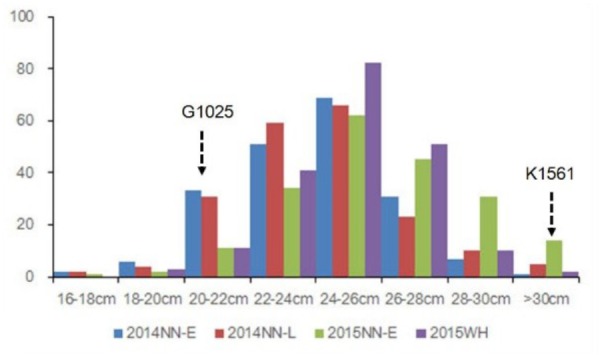
Phenotypic evaluation of PL for G1025, K1561, and RILs. The Y axis represents the number of plant individuals. The X axis is continuous for panicle length: 16 cm < PL ≤ 18 cm; 18 cm < PL ≤ 20 cm; 20 cm < PL ≤ 22 cm; 22 cm < PL ≤ 24 cm; 24 cm < PL ≤ 26 cm; 26 cm < PL ≤ 28 cm; 28 cm < PL ≤ 30 cm; PL > 30 cm.